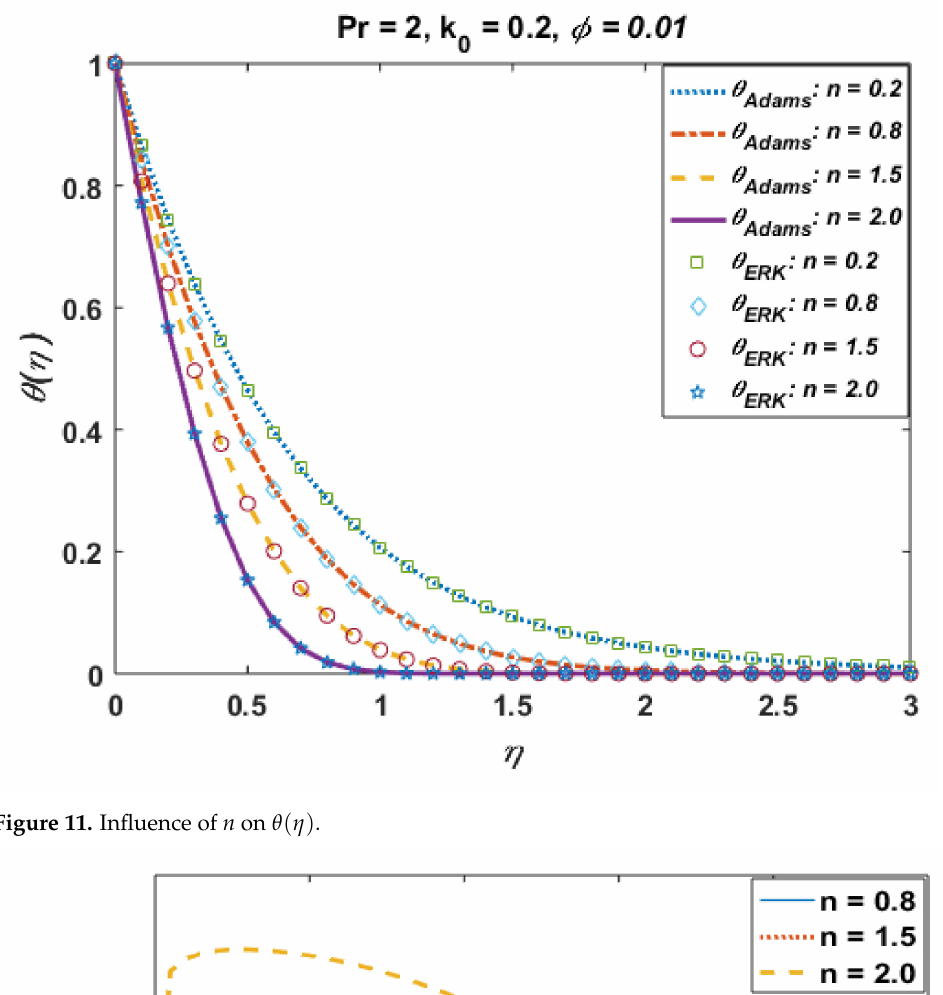
Figure 11. Influence of n on θ ( η ) .